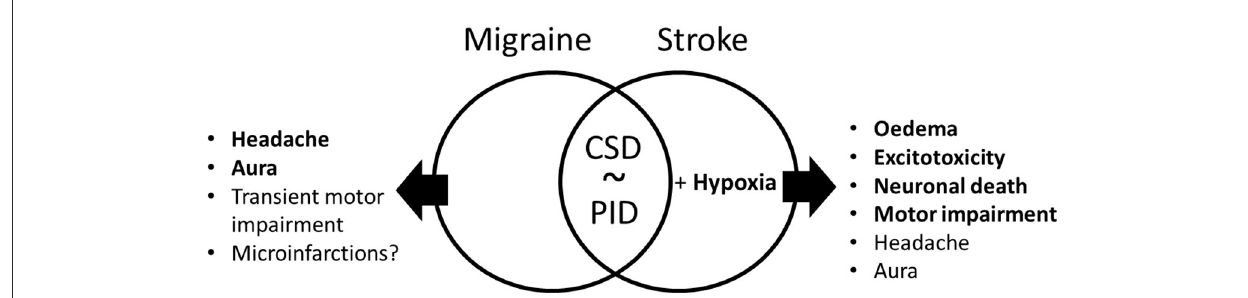
FIGURE1 Common and distinct symptoms and mechanisms in migraine and stroke. Both migraine and stroke might have common symptoms, such as headache and aura, as well as sustained in stroke and transient in familial hemiplegic migraine motor impairment. The central mechanism in stroke is neuronal death, while there is some evidence of the presence of microinfarctions in migraine. The best obvious common mechanism of the two disorders is cortical spreading depolarization (CSD) in migraine with aura that is similar to peri-infarct depolarization in ischemic stroke. The PID in stroke is also associated with local hypoxia, which exaggerates the outcome of this pathology via edema, excitotoxicity, and finally leads to neuronal